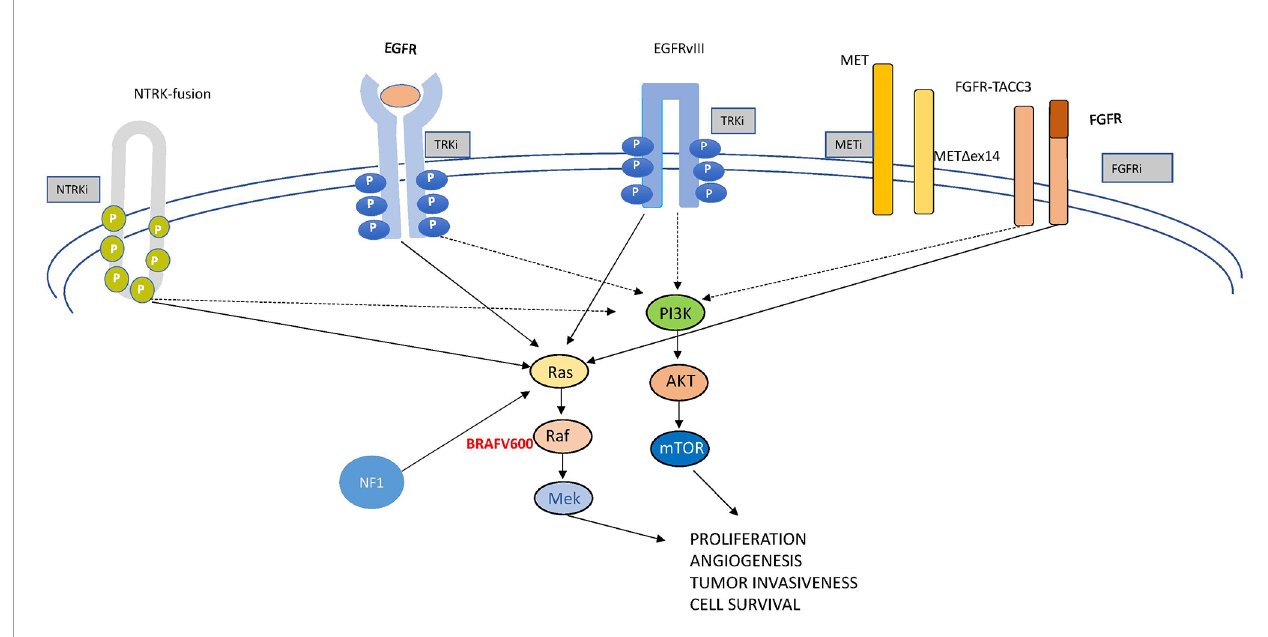
FIGURE 2 | A comprehensive representation of the relevant pathways in glioblastoma.